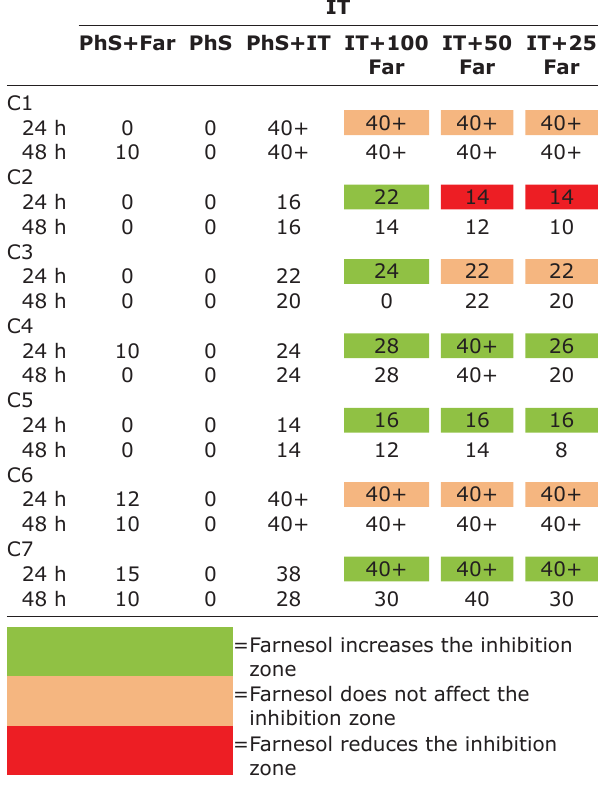
Table-8: Intraconazole sensitivity determination of 7 Candida albicans strains and the effect of farnesol three concentrations on these